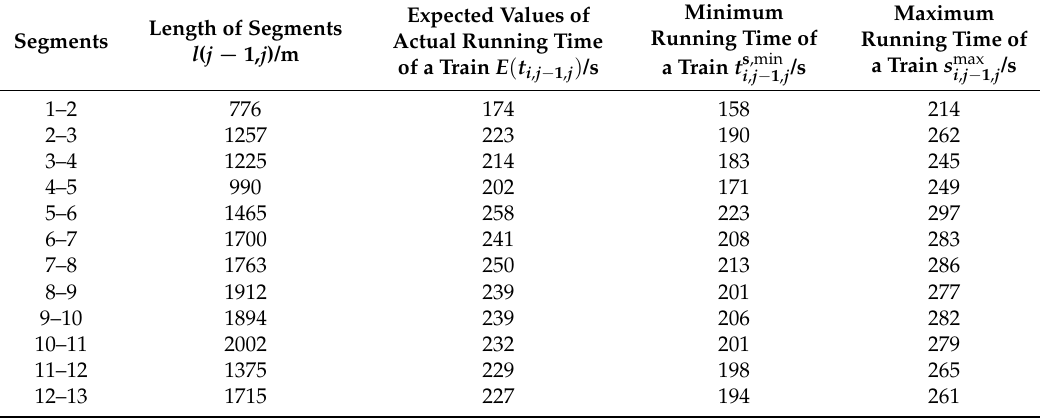
Table 2. The specific input data on segments.